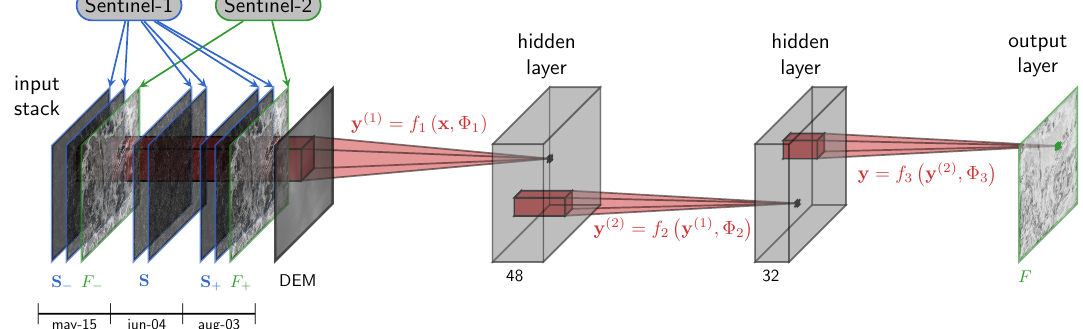
Figure 3. Proposed CNN architecture. The depicted input corresponds to the Optical-SAR+ case. Other cases use a reduced set of inputs. Table 1. CNN hyper-parameters: # of features, M ; kernel shape for each feature N parameters to learn for each layer given by MNK 2 (for w ) + M (for b ). In addition, in the last row